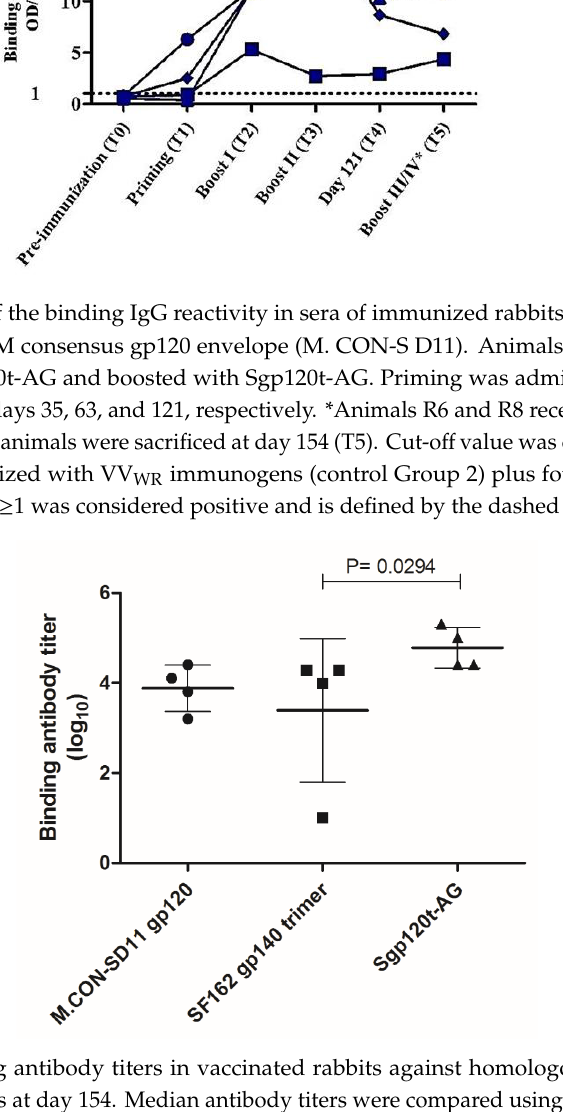
Figure 6. IgG binding antibody titers in vaccinated rabbits against homologous and heterologous envelope glycoproteins at day 154. Median antibody titers were compared using the Mann – Whitney U test. The lines represent mean and standard deviation values.